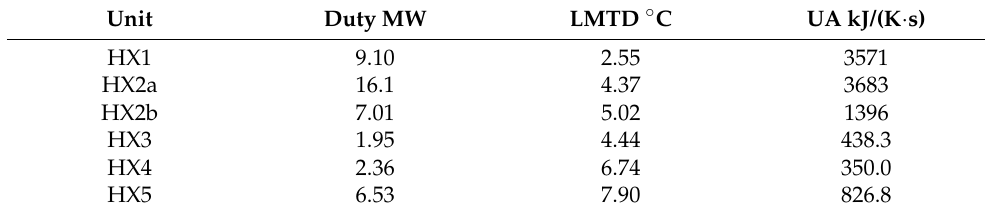
Figure 10. Temperature profiles for plate-fin heat exchanger HX2b. Table 2. Summary of heat exchanger